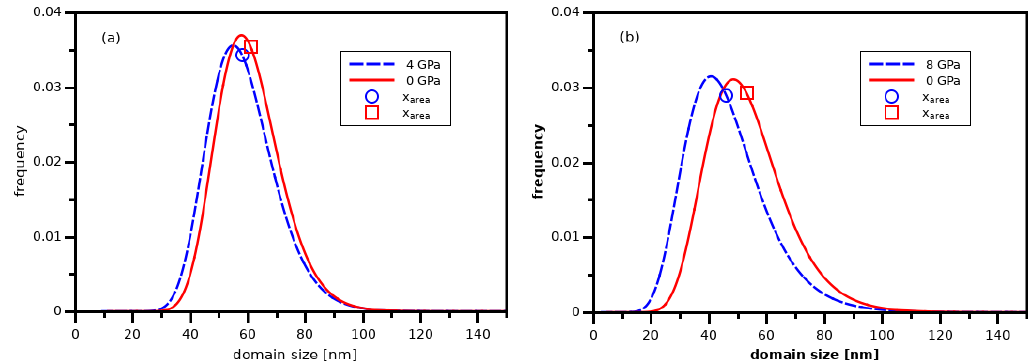
Figure 6. Size distributions of the coherently scattering domains resulting from the CMWP fit for nickel after deformation at 4 GPa ( a ) and 8 GPa ( b ), respectively. “ p = 0 GPa” denotes the sample state after the pressure release